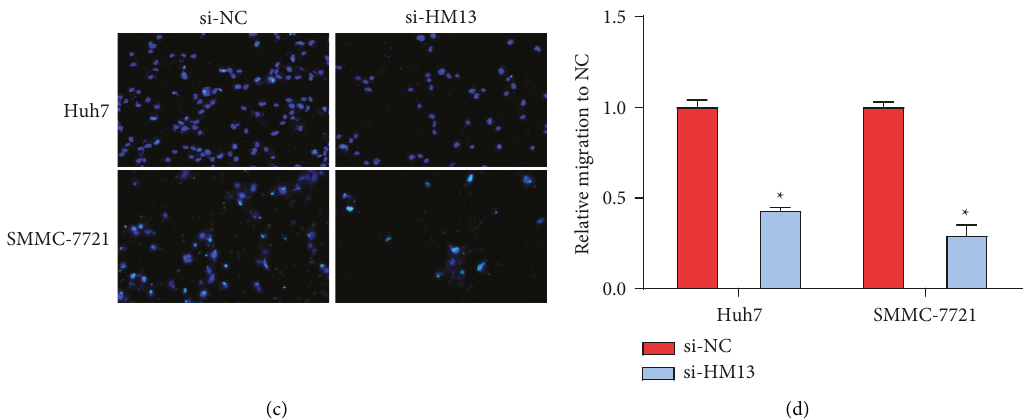
Figure 6: To evaluate the impacts of decreased HM13 on LIHC cell invasion and migration. (a–b) Evaluation of the influence of reduced HM13 on LIHC cell invasion ( ∗ P < 0 . 05; ∗∗ P < 0 . 01). (c–d) Validation of the effect of ablated HM13 on LIHC cell migration ( ∗ P < 0 .